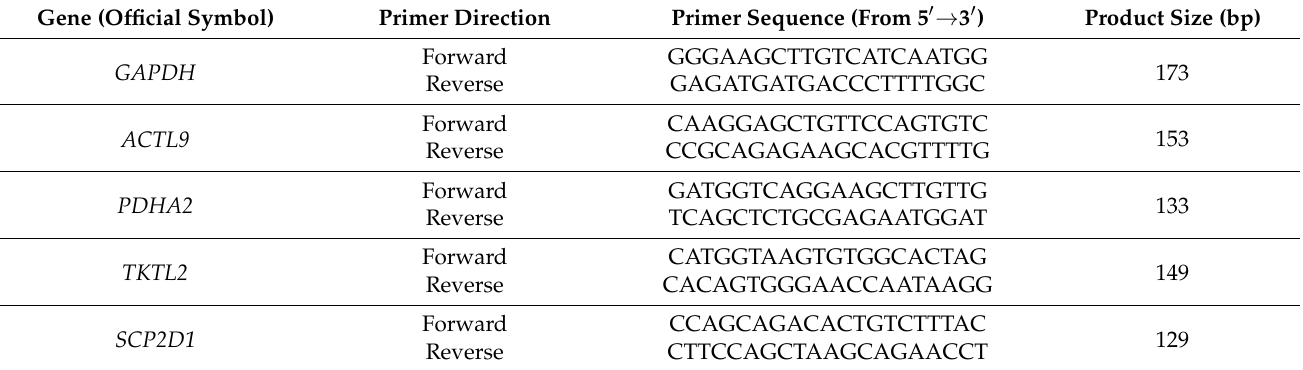
Table 2. Primer sequences for qRT-PCR and their expected amplicon